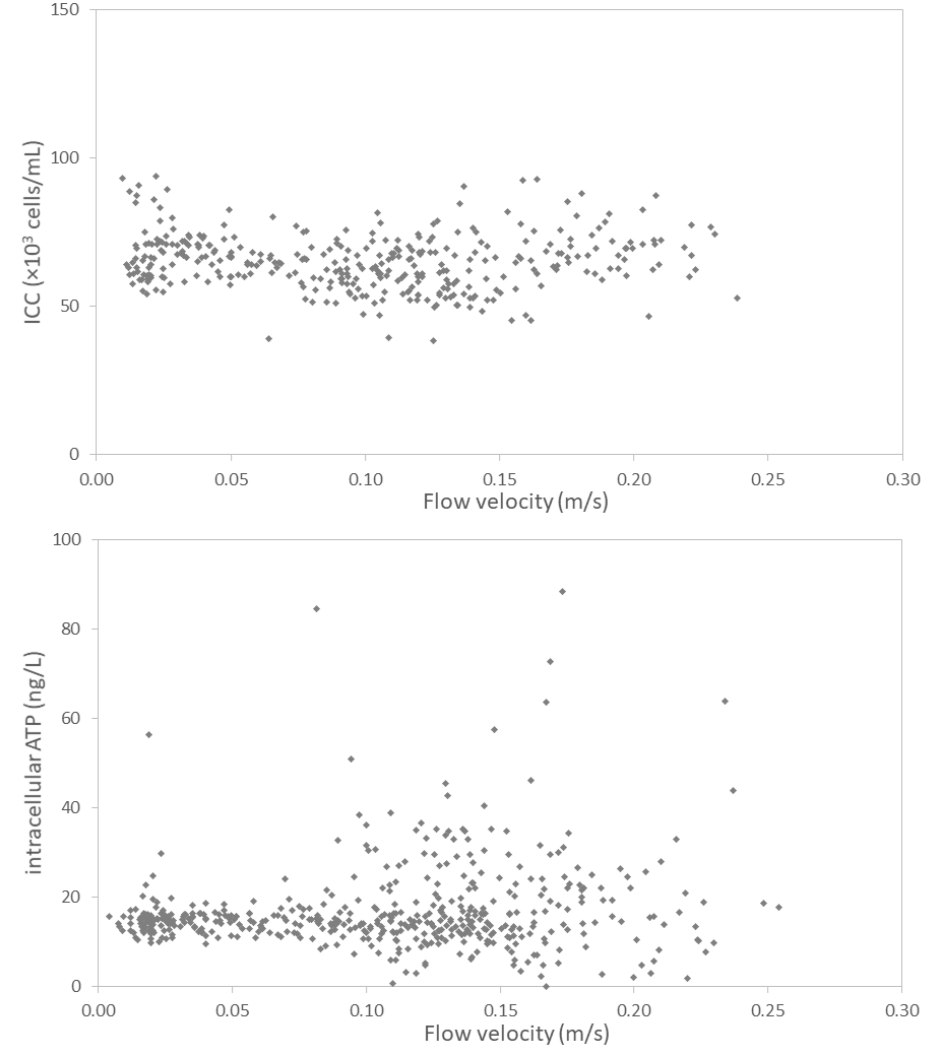
Figure 8. Relation between flow velocity and FCM intact cells (ICC, top figure ) and intracellular ATP ( bottom figure ) at distribution location E.